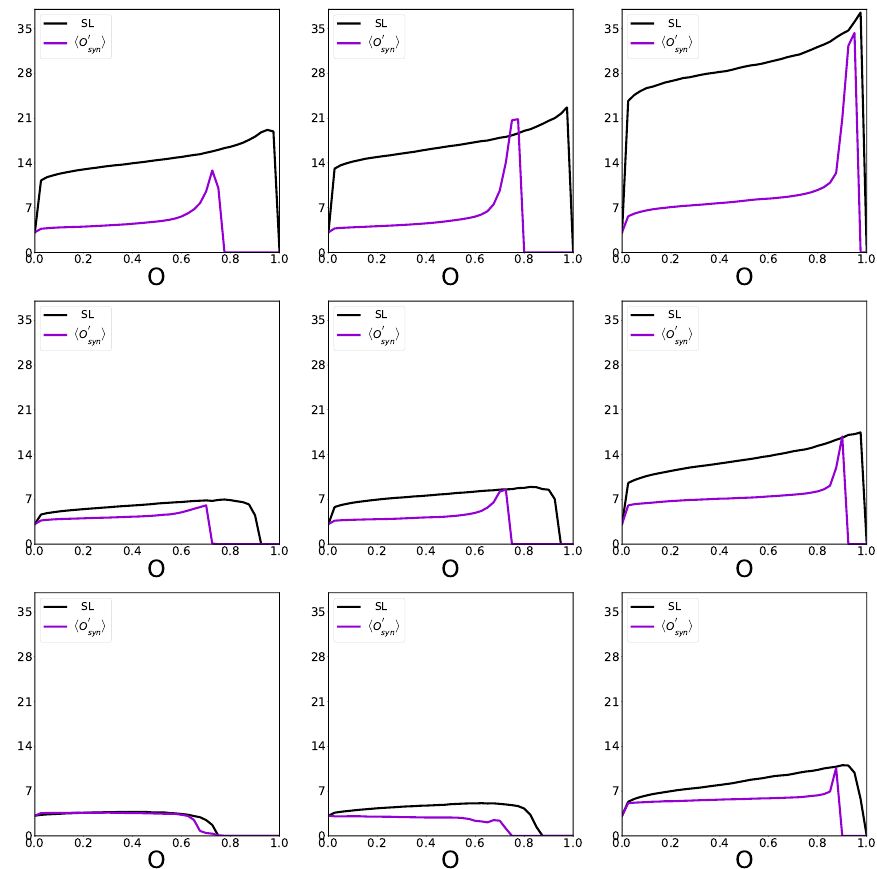
Figure 9 . Statistical significance as a function of the hO 0 syn i threshold (40 bins are defined), applied to the 2D Gaussian testing samples corresponding to the same BPs as in figure 3. Here r taken to define the signal-like sample S 0 for training O 0 also been